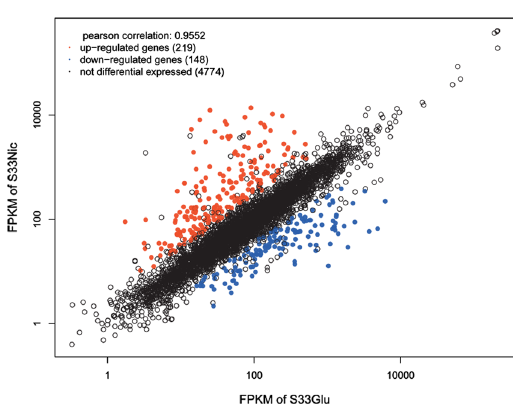
Figure 5. Scatter plot of FPKM values for genes expressed in A . tumefaciens S33 under two different nutrition conditions. S33Glu, cells grown in glucose-ammonium medium; S33Nic, cells grown in nicotine medium. The differentially-expressed genes were analysed based on S33Nic VS